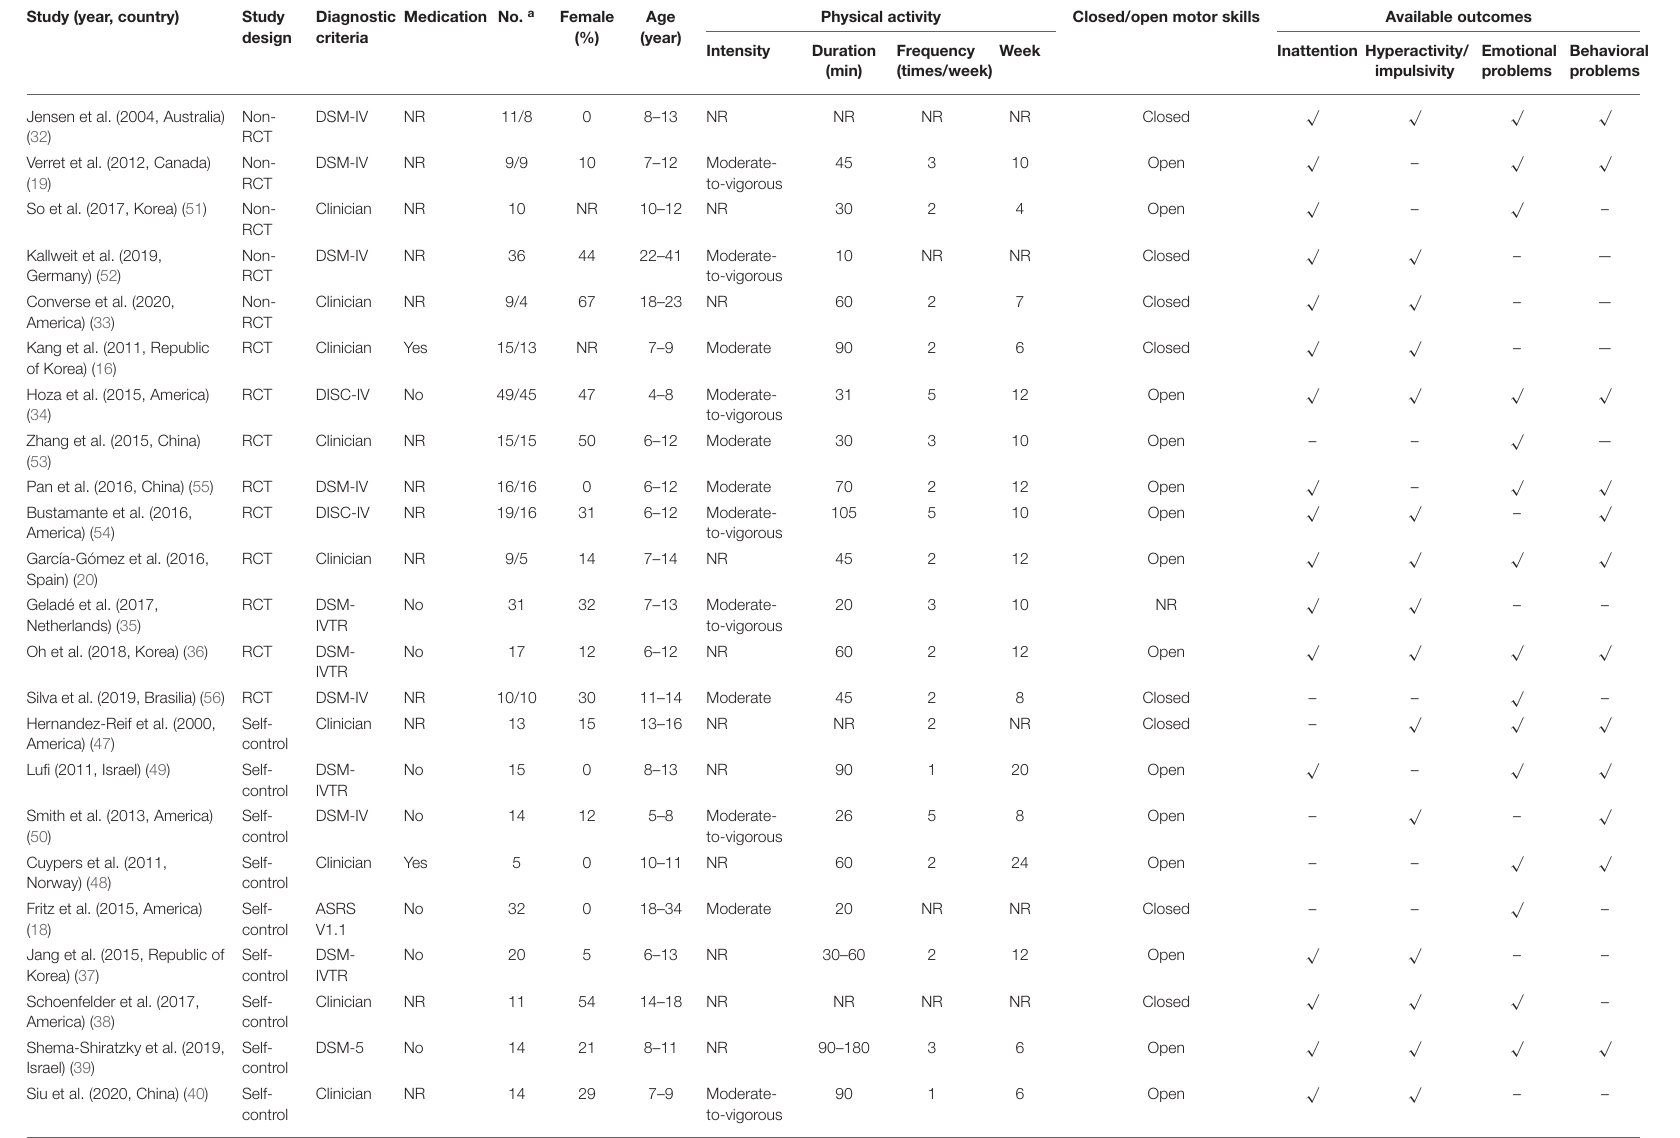
TABLE 1 | Summary of design and participant characteristics of studies included in